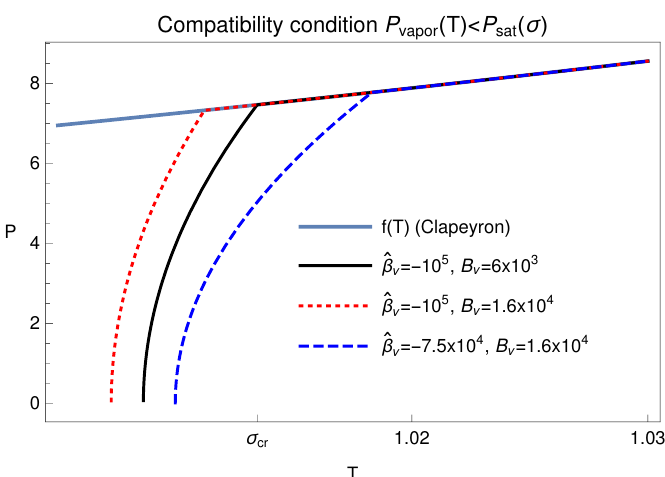
Figure 5. Check of the compatibility condition in Equation (18) for case